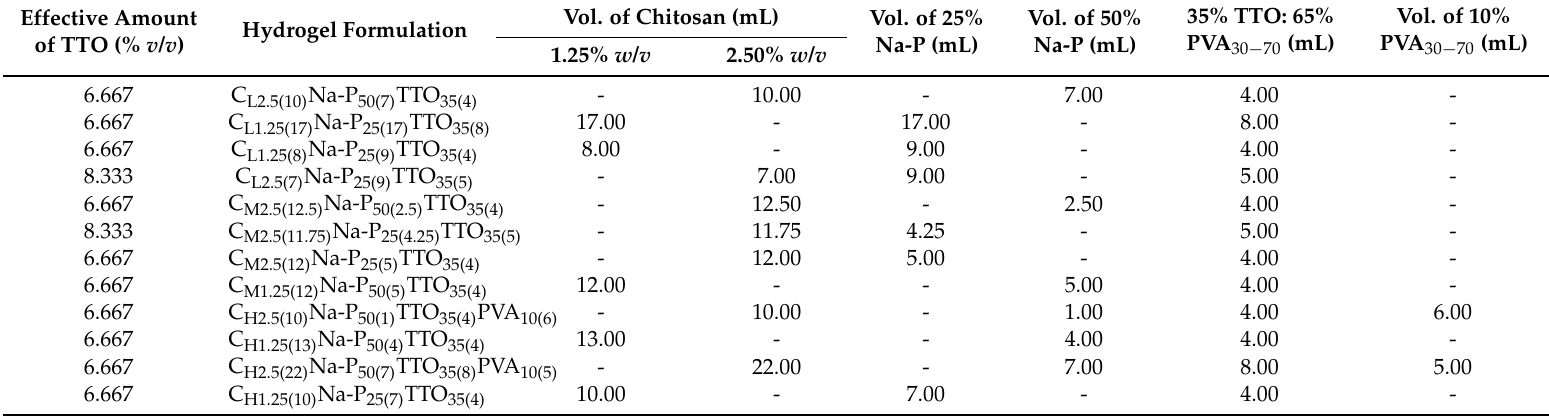
Table 1. Formulation details of hydrogels containing Tea tree oil (TTO) and/or silver ions (Ag + ). I. TTO